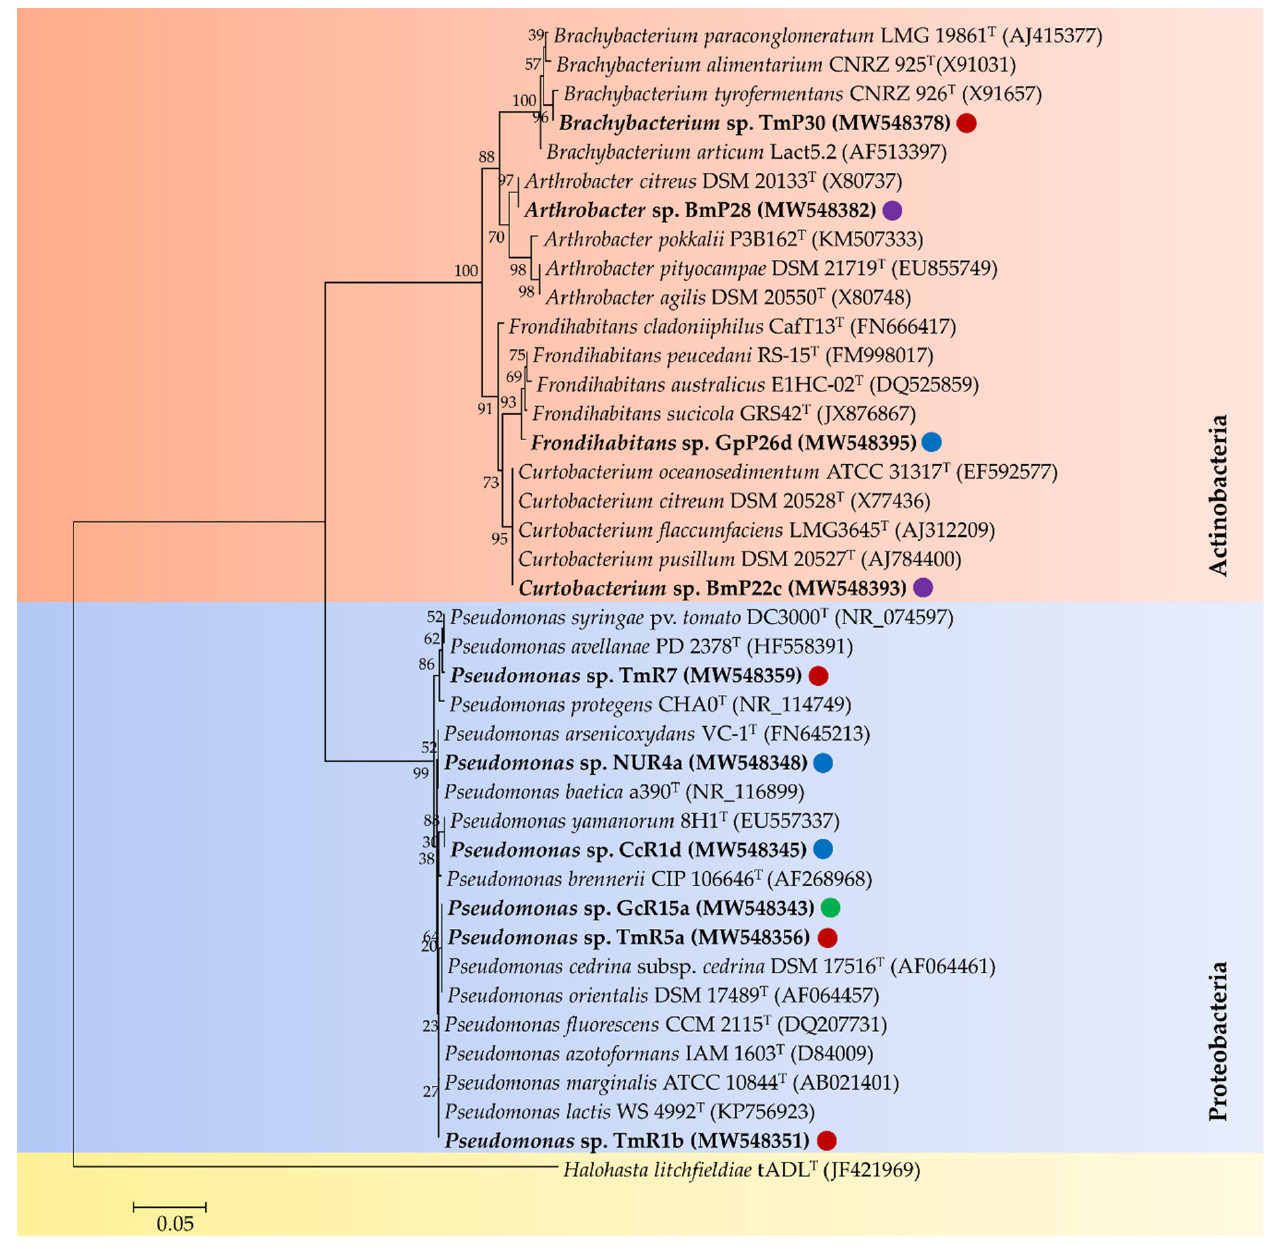
Figure 4. Phylogenetic tree of the 10 selected psychrotolerant strains for the formation of potential bacterial consortia. The dendrogram was constructed using the Neighbor-Joining method based on the partial sequence of the 16S rRNA gene. The tree has arbitrarily been rooted by the Antarctic archaeon Halohasta litchfieldiae . Values of 1000 bootstraps are informed at the branching point. GenBank accession numbers of 16S rRNA sequences are indicated in parentheses. Scale bar represents 0.05 substitutions per nucleotide positions. The circles represent the regions of Chile. Red circles, Valparaíso Region; Green circles, Libertador General Bernardo O’Higgins Region; blue circles, Ñuble Region; and purple circle, Magallanes and Chilean Antarctica Region.